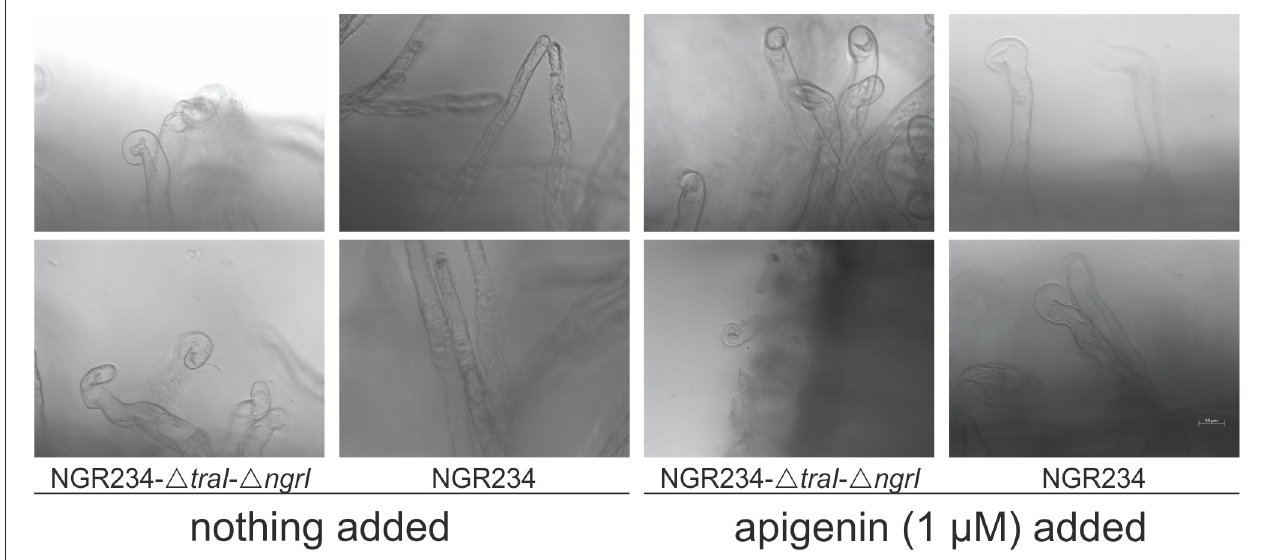
FIGURE 4 | Root hair curling assays using Nod factor extracts of Sinorhizobium fredii NGR234 and the NGR234- 1 traI - 1 ngrI double deletion mutant. Images in the upper and lower panel show root hair curling after 24 h induction with extracts of cultures treated either with 1 µ M apigenin or the non-treated controls for the parent strain and the NGR234- △ traI - △ ngrI double deletion mutant.